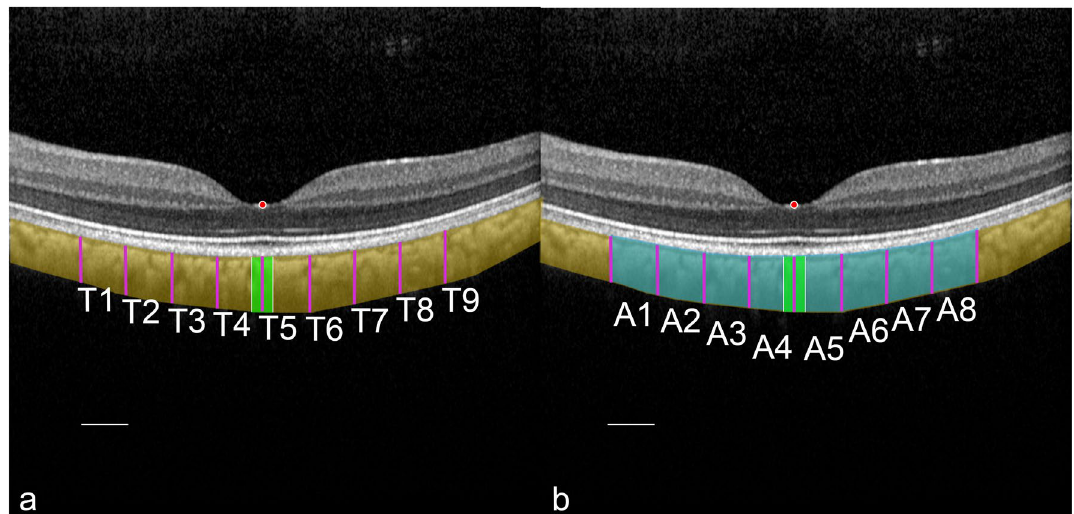
Figure 2. Designation of the anatomical choroidal landmarks in the left eye with relation to the deepest location of the foveola. ( a ) In a cross-sectional B-scan of a healthy macaque, the deepest location at the bottom was automatically identified and marked as a nulla (red dot). Below the nulla, consecutive measurements of choroidal thickness were conducted at 500 µm intervals up to 2000 µm to the side (marked as thickness T1–9, purple diameters). ( b ) In between the choroidal thickness diameters, the eight choroidal surface areas were defined (A1–A8, highlighted in light blue) and measured. With respect to the central bouquet of cones (highlighted in light green), umbo choroidal subfield analysis was similarly performed at distances of 100 µm to determine additional choroidal parameters for the umbo choroidal nasal and temporal thicknesses (a, white lines) and the umbo choroidal nasal and temporal surface areas ( b ). The same procedures were performed for all eyes. Bars = 500